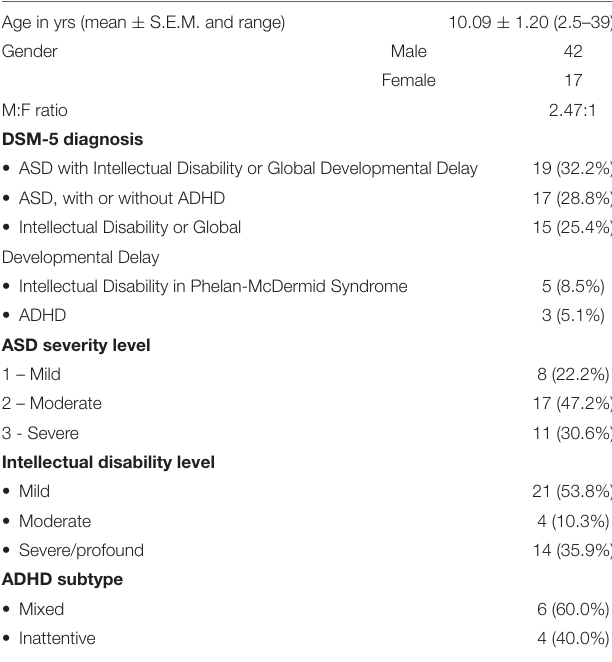
TABLE 2 | Demographic and clinical characteristics of the sample ( N = 59).